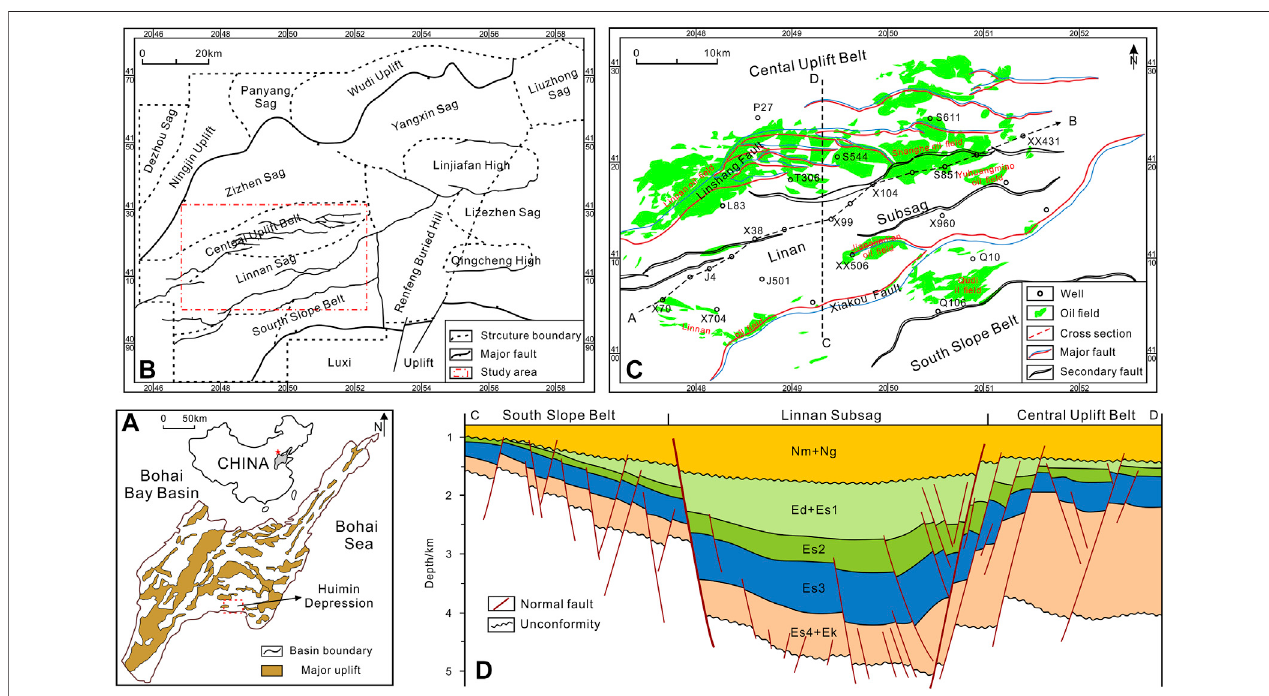
FIGURE 1 | Division of structural units and well distribution of the Linnan Sag. (A) The structure of the Bohai Bay Basin and the location of the Huimin Depression. (B) Structural units of the Huimin Depression. (C) Tectonic setting ofthe Linnan Sag with the locations of wells. (D) Schematic north – south geologic cross section of the Linnan